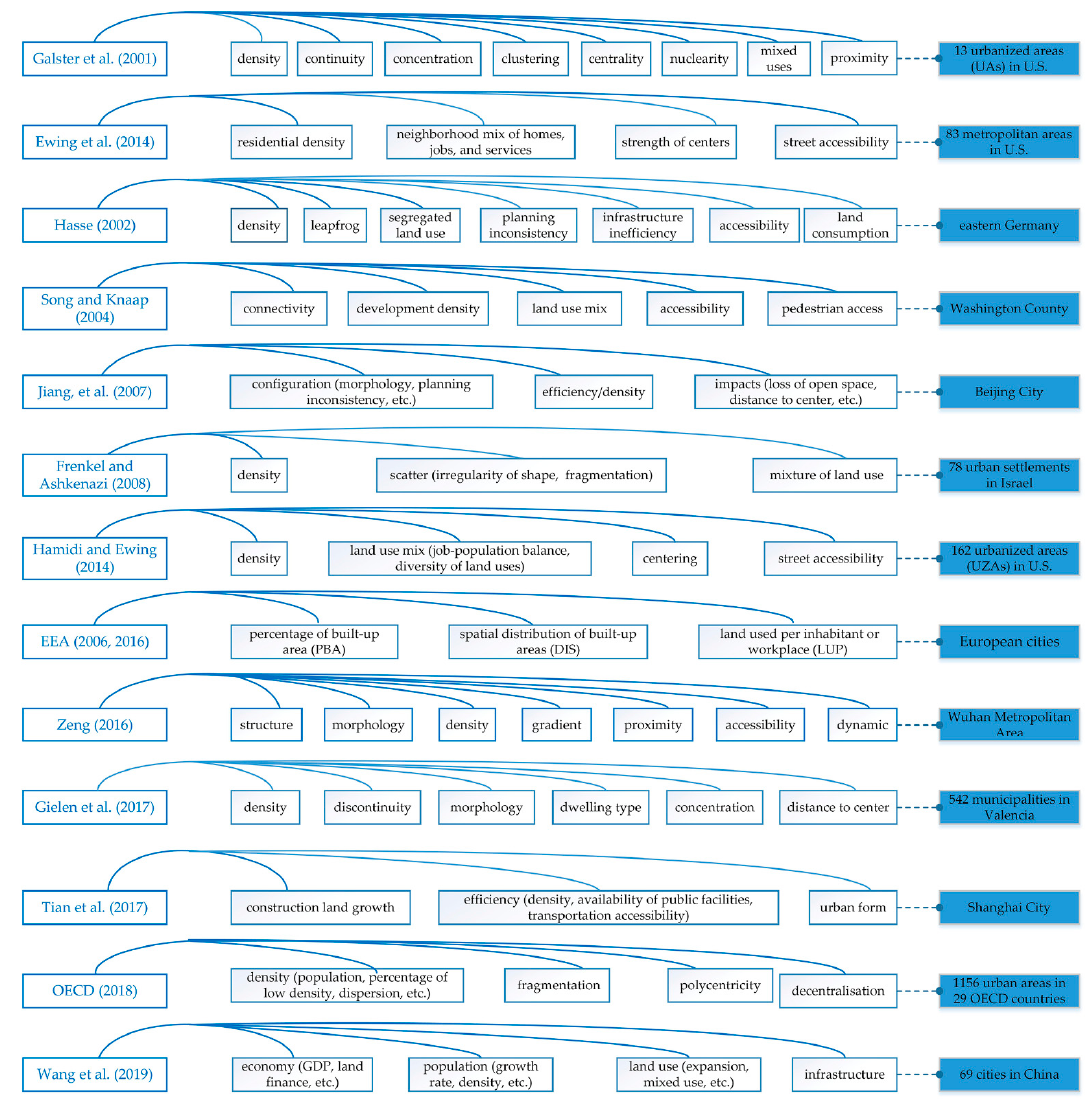
Figure 4. Representative Multidimensional Measurements of Urban Sprawl.